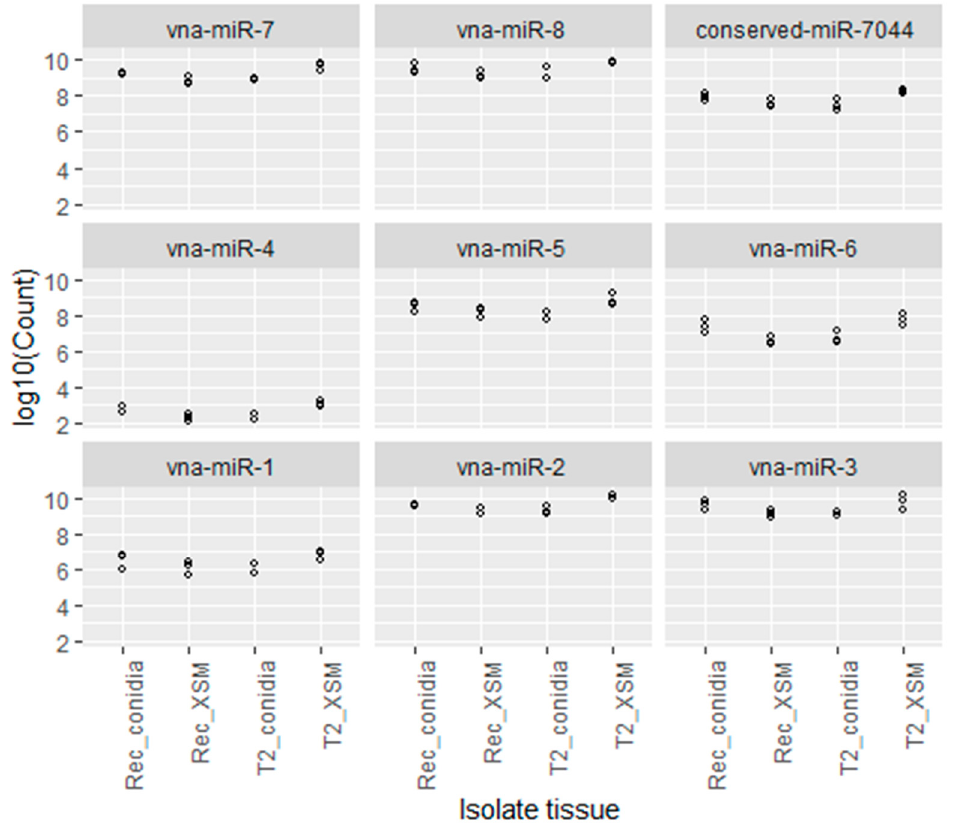
Figure 2. MilRNA copy number plotted on log10 scale for each confirmed V. nonalfalfae milRNA in each of the four investigated pathotype-tissue combinations; the use of 10 for the logarithmic base allows the power of the count values to be read directly from the plot. Statistically significant differences between the samples were tested using the one-way ANOVA methodology.